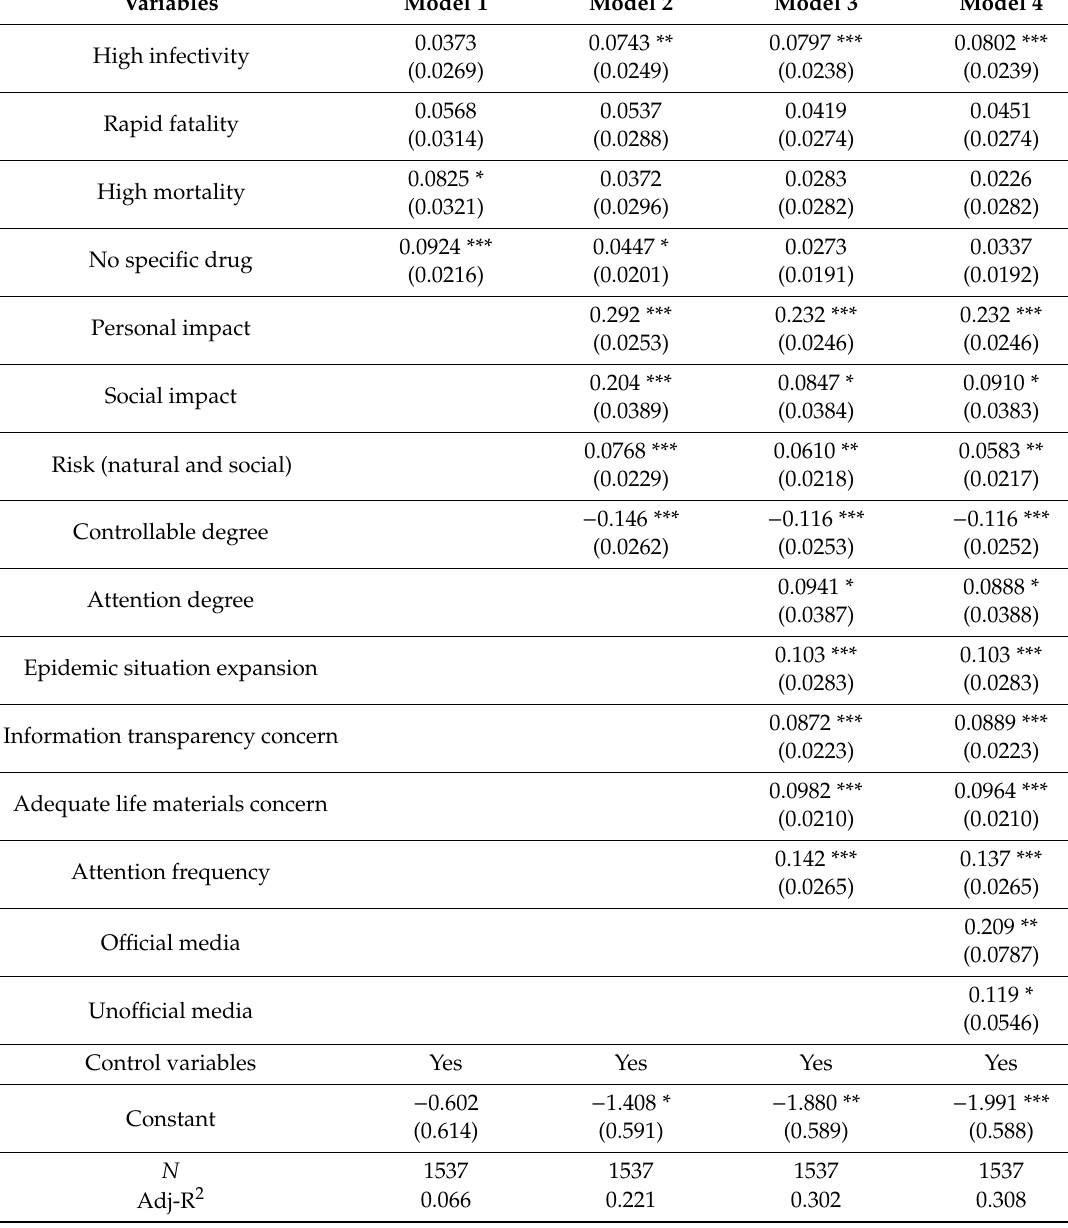
Table 3. Regression models of cognition, attention, and